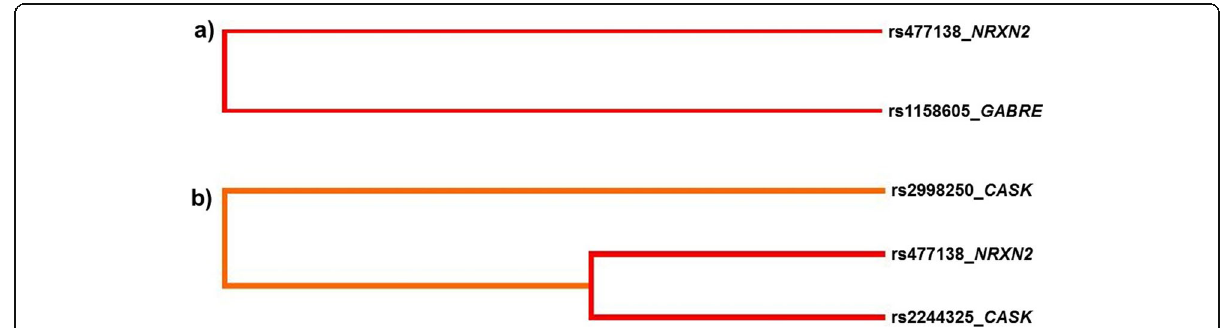
Fig. 1 Interaction dendrogram between a NRXN2-GABRE and b NXRN2-CASK in migraine susceptibility. The colour of the line indicates the type of interaction. Black and dark grey suggest a synergistic relationship. Shorter length of the lines shows a stronger